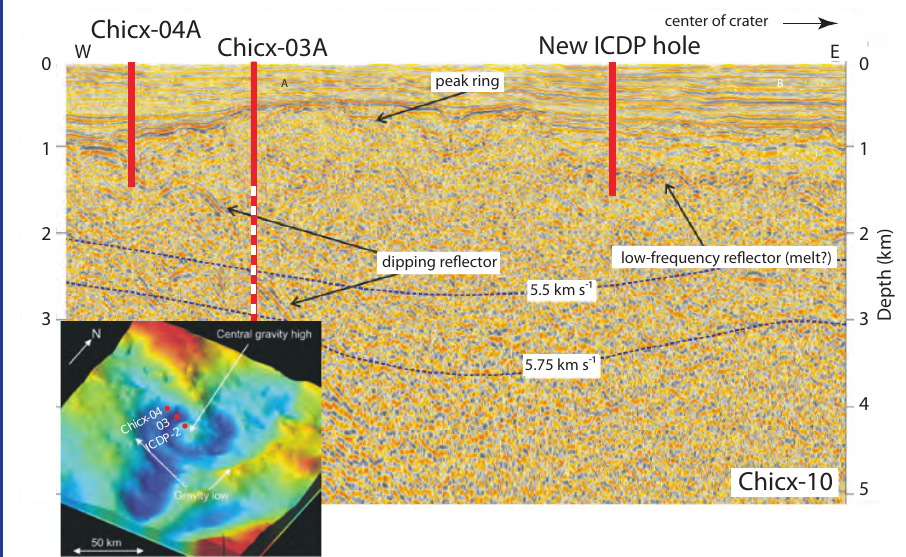
Figure 12. Seismic profile across Chicxulub, Mexico impact crater showing proposed drilling transect combining ocean and continental drilling. Drilling objectives include 1) earliest Tertiary sediments to document the resurgence of life, 2) impact-induced megabreccia and potential exotic organisms, 3) impact morphometric features, such as a peak ring, to constrain their origins, and 4) lithology of the melt sheet to differentiate among impact models (modified after Morgan et al., 2007). Inset shows gravity data over Chicxulub, revealing distinct crater structure and proposed IODP/ICDP drill sites (gravity image courtesy of Pilkington and A.R.